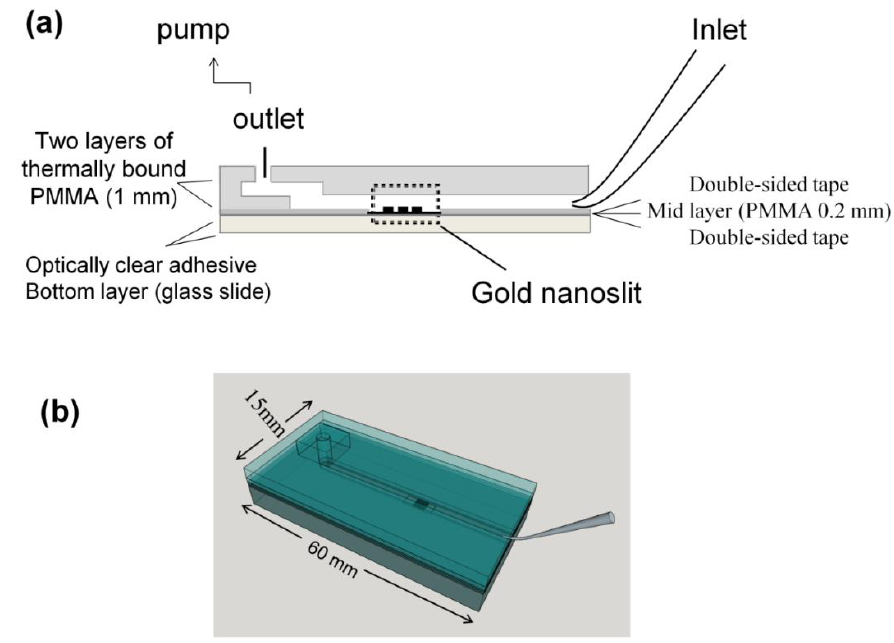
Figure 2. ( a ) The layered structure and ( b ) top view of the funnel chip integrated with a gold nanoslit